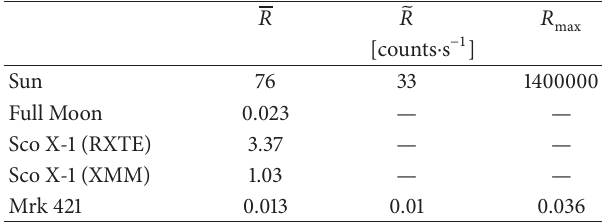
Table 4: Estimations of count-rates per second 𝑅 of selected observational candidates for X-ray optics with TimePix sensor onboard VZLUSAT-1 mission. Only the observational candidates with estimated chance of catching one photon per one minute are shown; the other candidates from Table 1 can be computed from